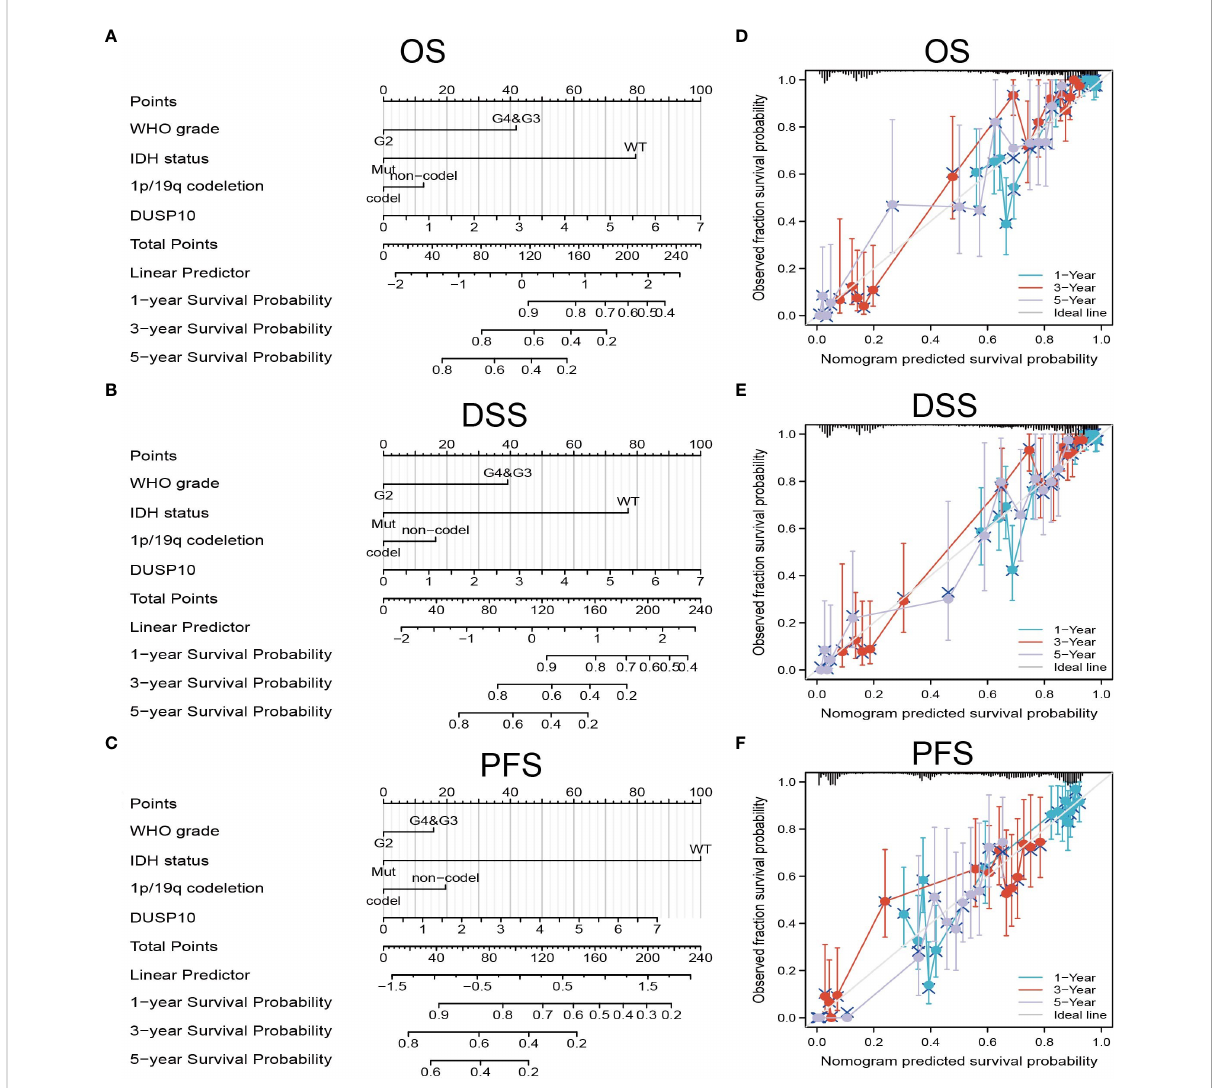
FIGURE 4 Construction and performance validation of the DUSP10-based nomogram for glioma patients. (A – C) The nomogram was constructed based on four factors for predicting 1-, 3-, or 5-year overall survival, disease-speci fi c survival, and progression-free survival of patients with glioma in TCGA database. (D – F) The calibration plots of internal validation in TCGA dataset showed good consistency in predicting 1-, 3-, or 5-year overall survival, disease-speci fi c survival, and progression-free survival of patients with glioma in TCGA database. TCGA, The Cancer Genome